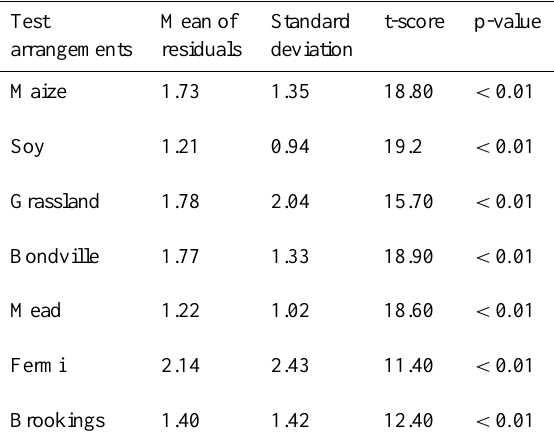
Presence of bias in reference evapotranspiration (Penman-Monteith) across crops and locations.